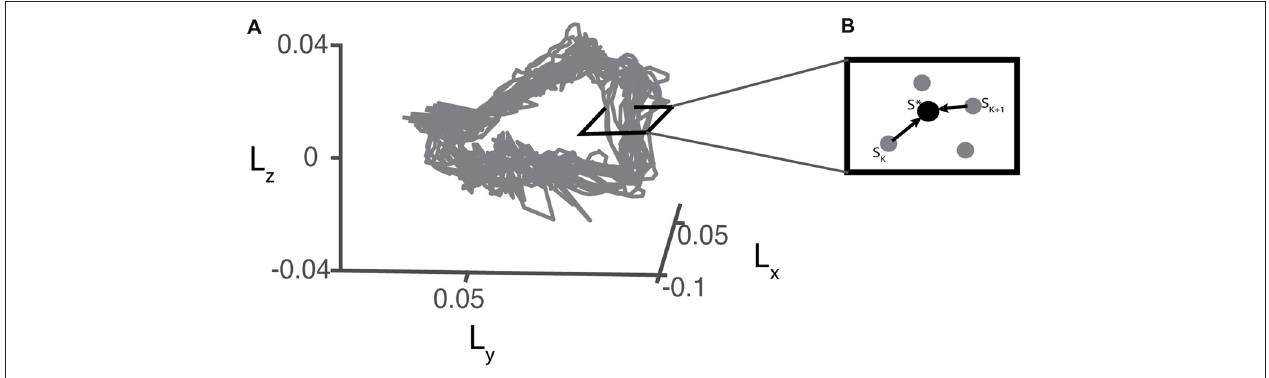
FIGURE 3 | (A) Example of a 3D projection of the angular momentum trajectory recorded during baseline walking for one representative participant. (B) Illustration of a hypothetical perpendicular slice of the angular momentum trajectory as a Poincare section. S ∗ represents the fixed point which is the average of pre-perturbation